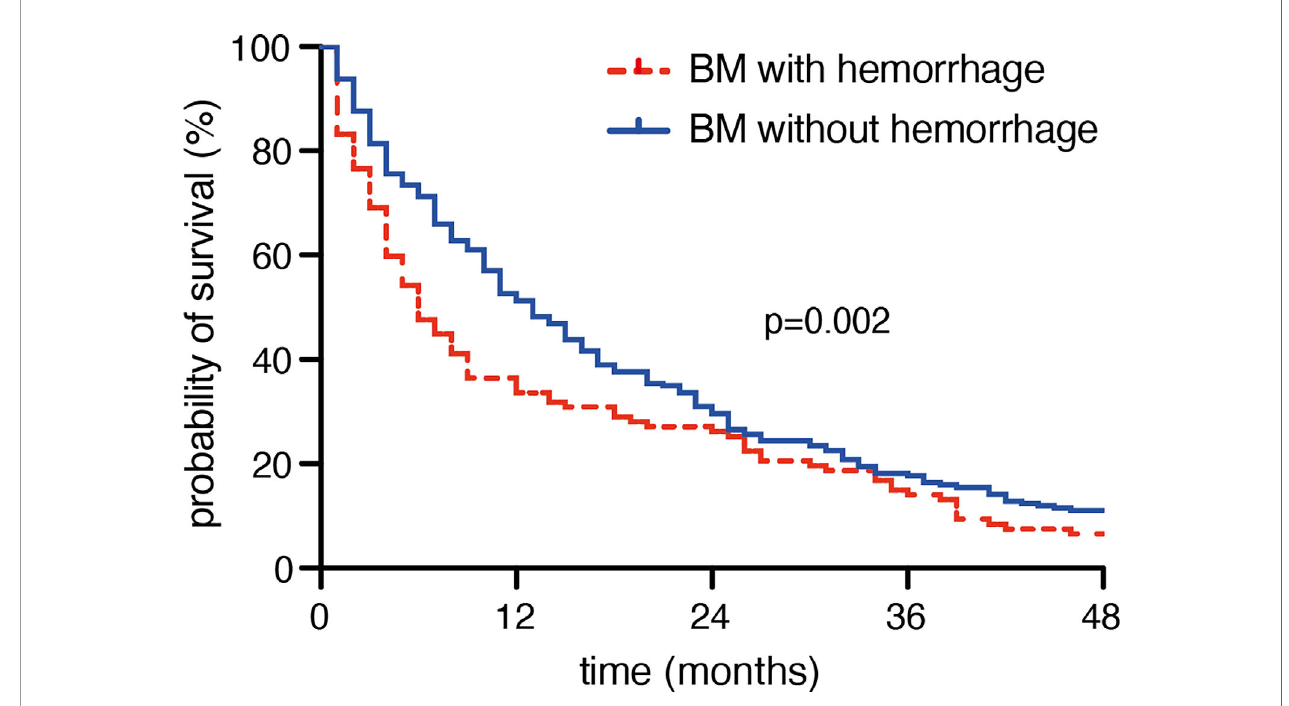
FIGURE 1 | Preoperative hemorrhage is associated with poor survival in patients with brain